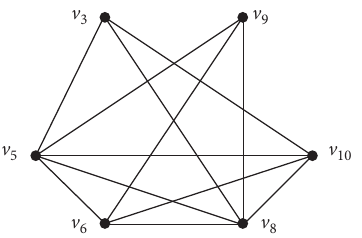
Figure 4: Graph G I ( Λ ), where Λ = < 3, 5, > and I ={11, 12,